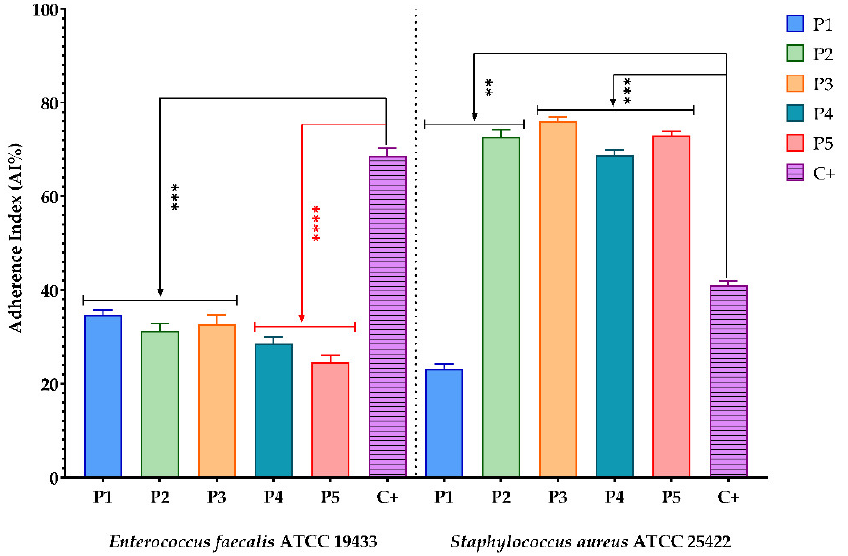
Figure 1. Graphic representation of AI% values representing the influence of BPE on adherence capacity of Gram-positive bacteria; (P1–P5)-BPE samples; (C+)-bacterial adherence control. The differences between antibacterial activity of BPE samples and bacterial adherence control were statistically analysed by performing one-way ANOVA, followed by Dunnett’s multiple comparisons. (** p < 0.005; *** p < 0.001; **** p < 0.0001).